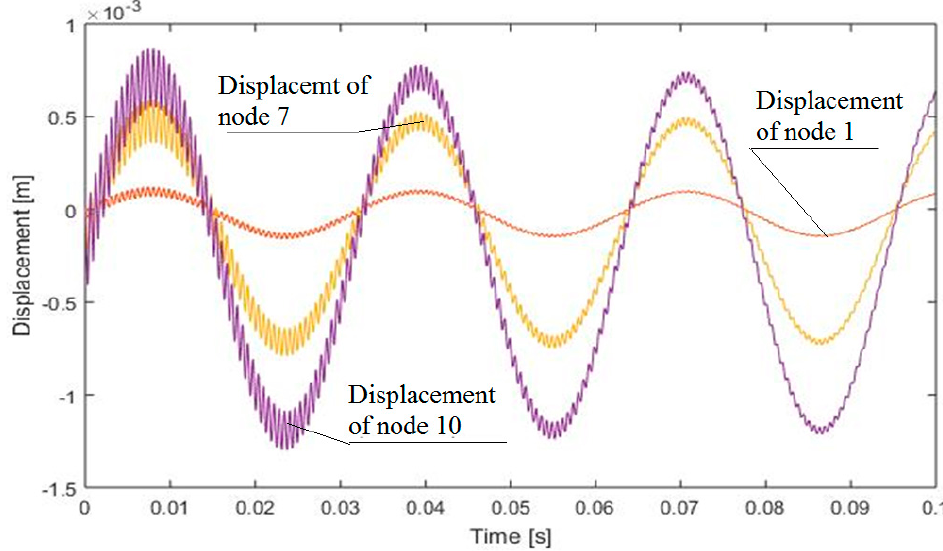
Figure 3. Axial displacement of the node 3, 7, 10 (10 finite elements, 11 nodes) with damping .